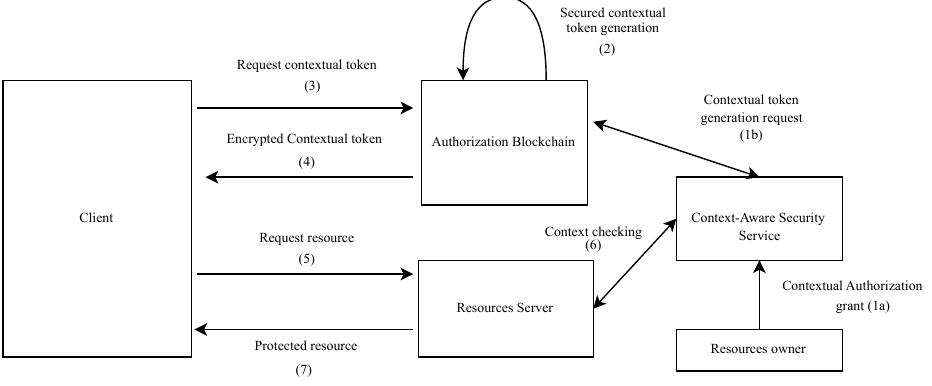
Figure 5. Proposed framework detailed